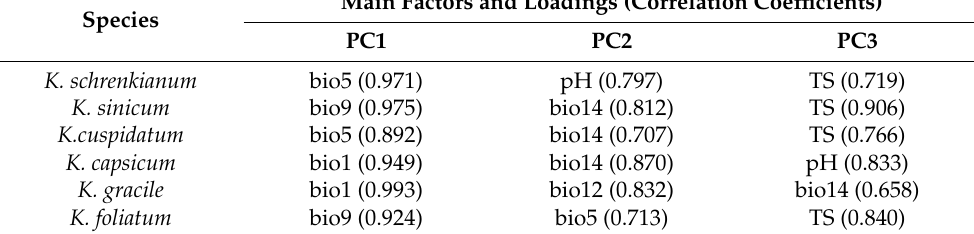
Table 2. Loadings of the main factors influencing the first three Principle Components obtained from Principle Component Analysis of the relationships between abiotic factors and distributions of the six Kalidium